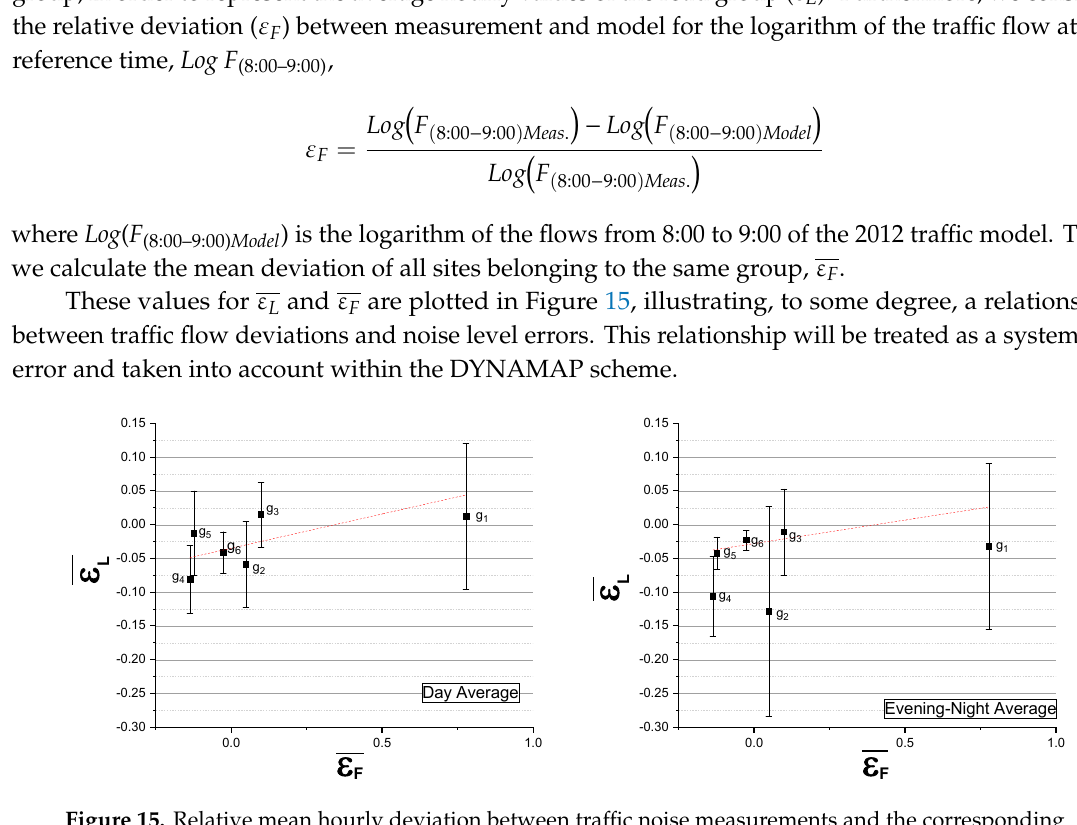
Figure 15. Relative mean hourly deviation between tra ffi c noise measurements and the corresponding DYNAMAP predictions ε F vs. the relative deviation between the logarithm of tra ffi c flow measurements and the corresponding model calculations at the reference hour (8:00–9:00) ε F for each group separately. The results refer to: Day time (07:00–21:00) (Left panel), and Evening-Night time (21:00–07:00) (Right panel) periods. The dashed line is just a guide for the eye.